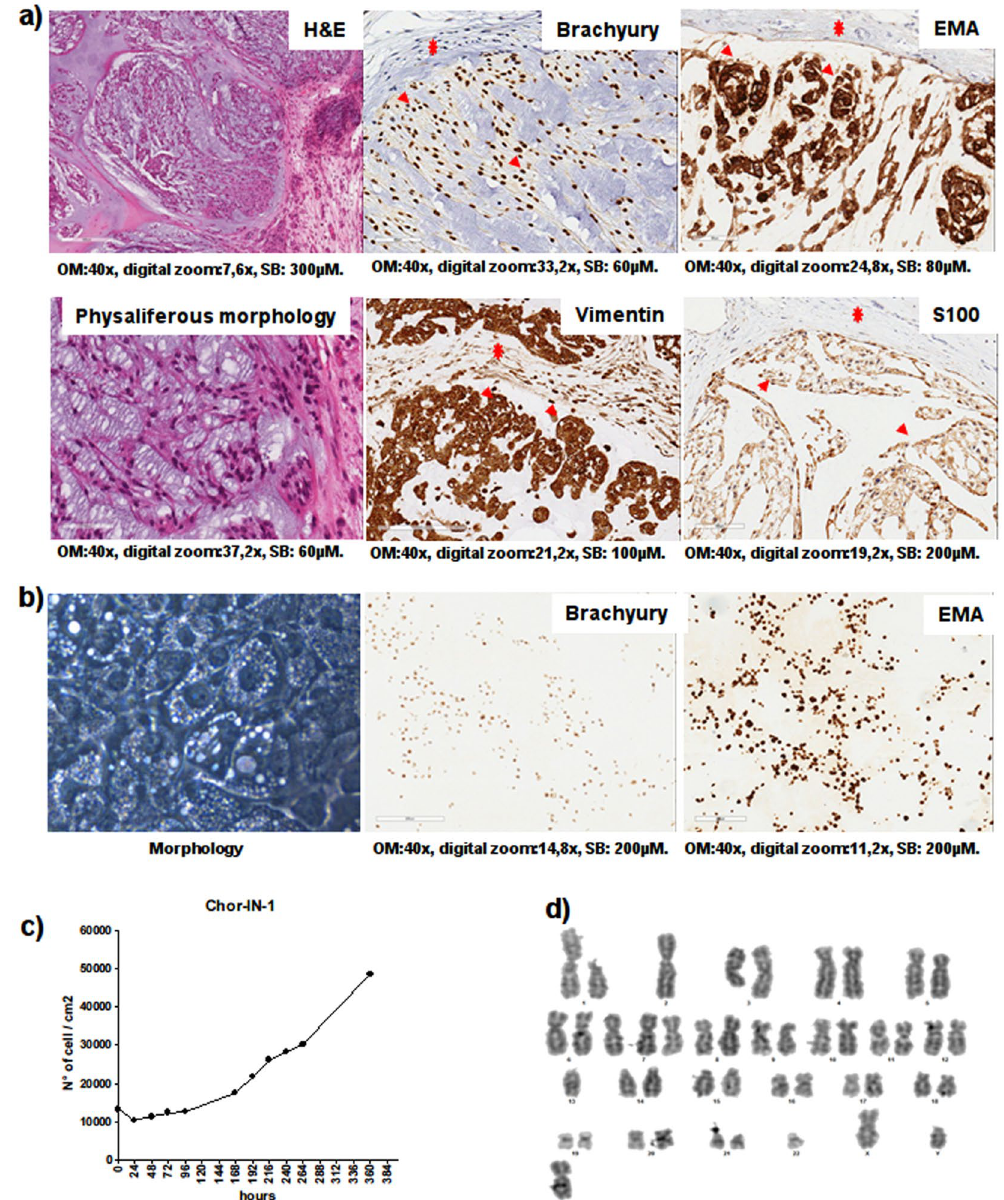
Figure 1. Tumor and Chor-IN-1 cell line characterization by H&E and IHC. ( a ) The original tumor sample and ( b ) the derived Chor-IN-1 cell line were characterized by H&E, revealing the typical physaliferous cells, and by IHC, showing positivity for brachyury and for other chordoma typical biomarkers, as indicated. In ( a ), arrows and stars indicate examples of tumor and fibroblast cells, respectively. ( c ) Growth curve: the doubling time of Chor-IN-1 cell line was calculated as reported and found to be of about seven days. ( d ) Karyotype analysis of Chor-IN-1 cell